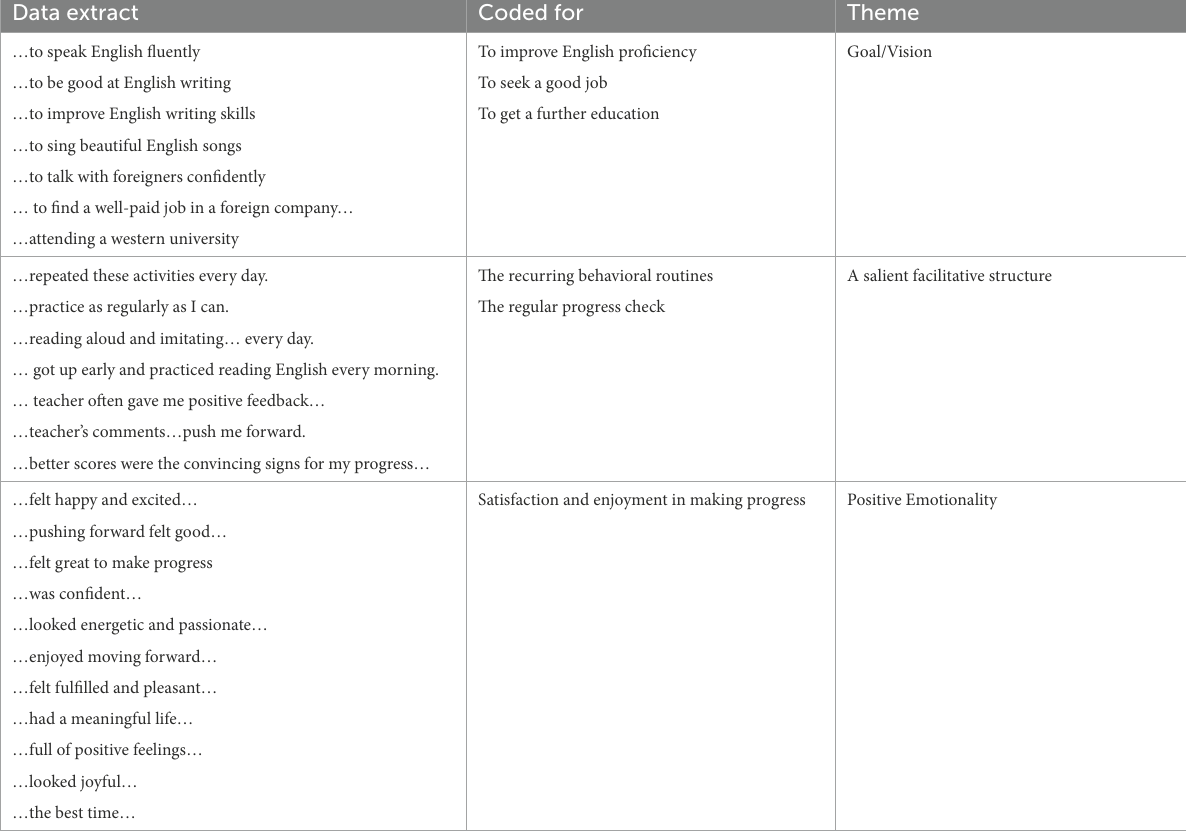
TABLE 2 The coding scheme for the core features of DMCs in participants’ motivation stories. Data